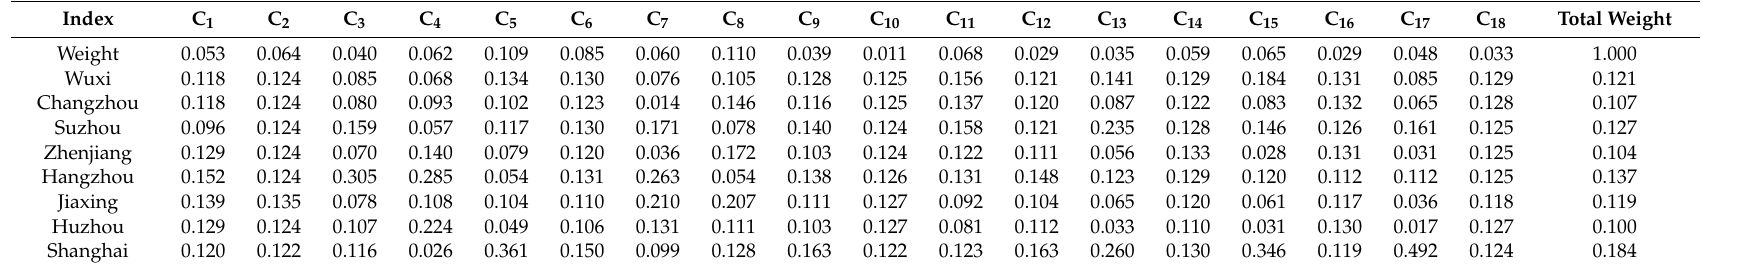
Table 7. Results of initial allocations of flood drainage rights in each administrative region.